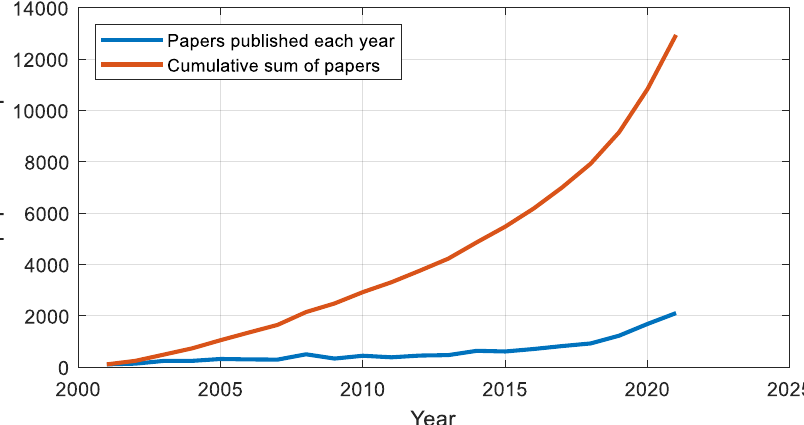
Figure 1. Published articles (in Scopus) using AI in civil engineering-related fields (2000 – 2021).